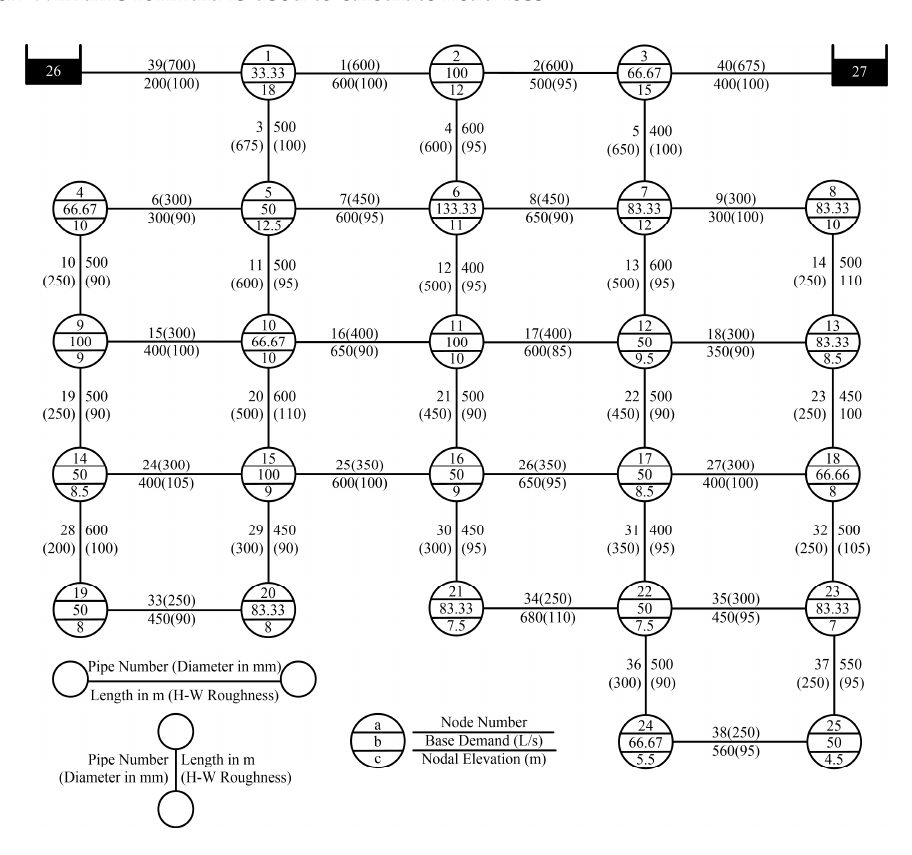
Figure 1. The layout for the water distribution network (WDN).